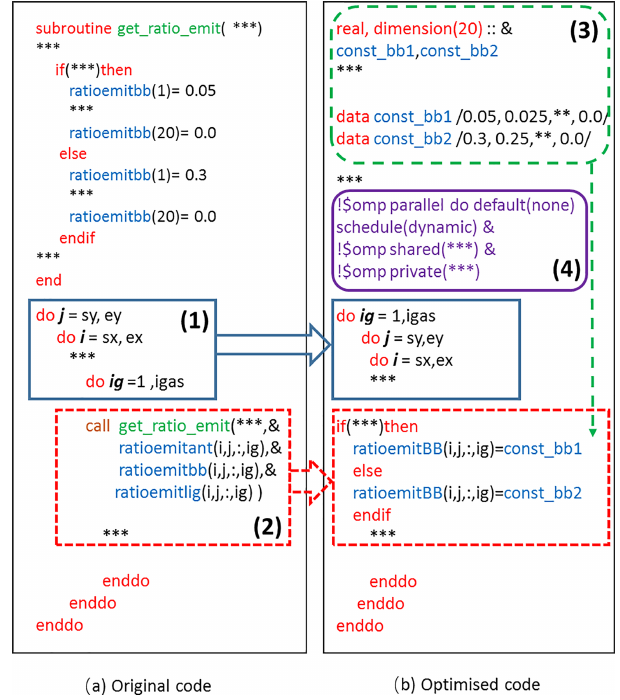
Figure 3. Sample codes containing some typical optimisation meth- ods. Panel (a) is the original code and panel (b) is the optimised code. Step (1) changes the order of the i, j, ig loops, and step (2) makes the subroutine inline. Step (3) uses the parameter to convert the scalar codes to vector codes, and step (4) adds the OpenMP